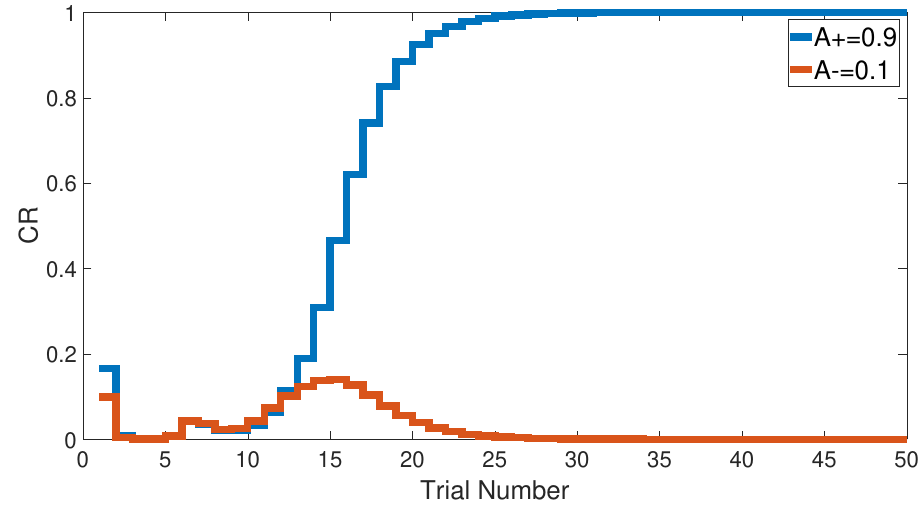
Figure 17. Easy transfer task for the intact system.